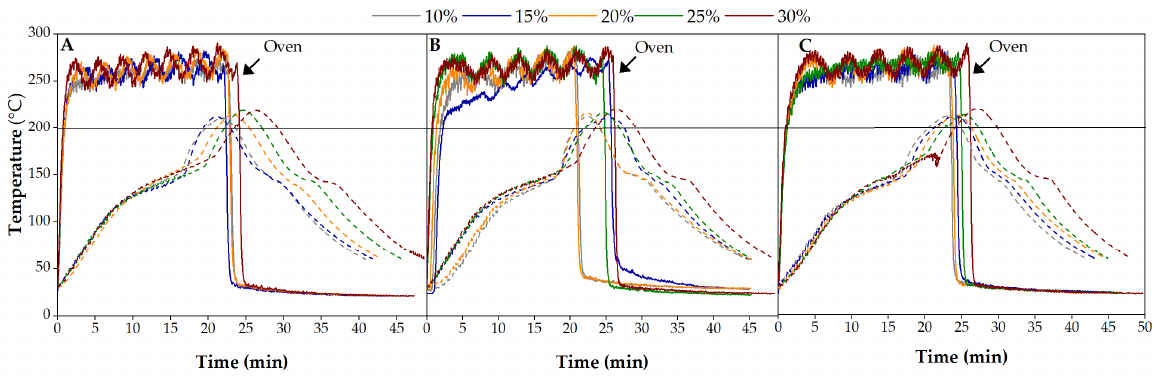
Figure 7. Oven and mold internal air temperature profiles during the processing cycle of MDPE/wood composites by rotational molding. Effect of wood content and its granulometry: ( A ) <150 µm; ( B ) 150–300 µm and ( C ) 300–500 µm.